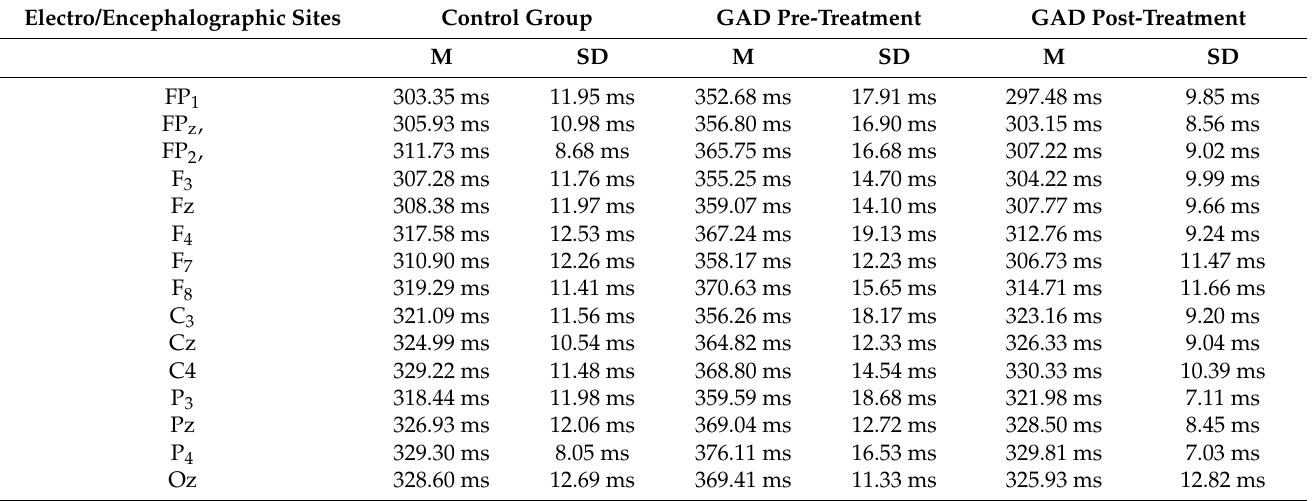
Table 1. The mean scores, standard deviations of P300 latency from all recorded brain areas from children and adolescents that participated in the control group, and children and adolescents that were diagnosed with GAD pre- and post-treatment.